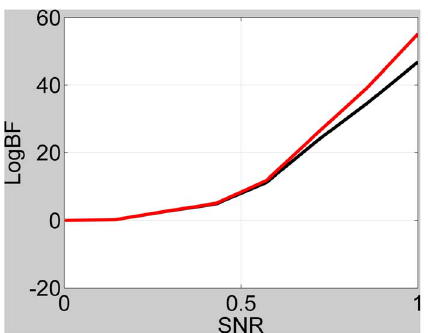
Figure 2. Log Bayes factor versus SNR for full versus reduced model, when full model is true, for IMO approach (black line) and Savage-Dickey (red line).